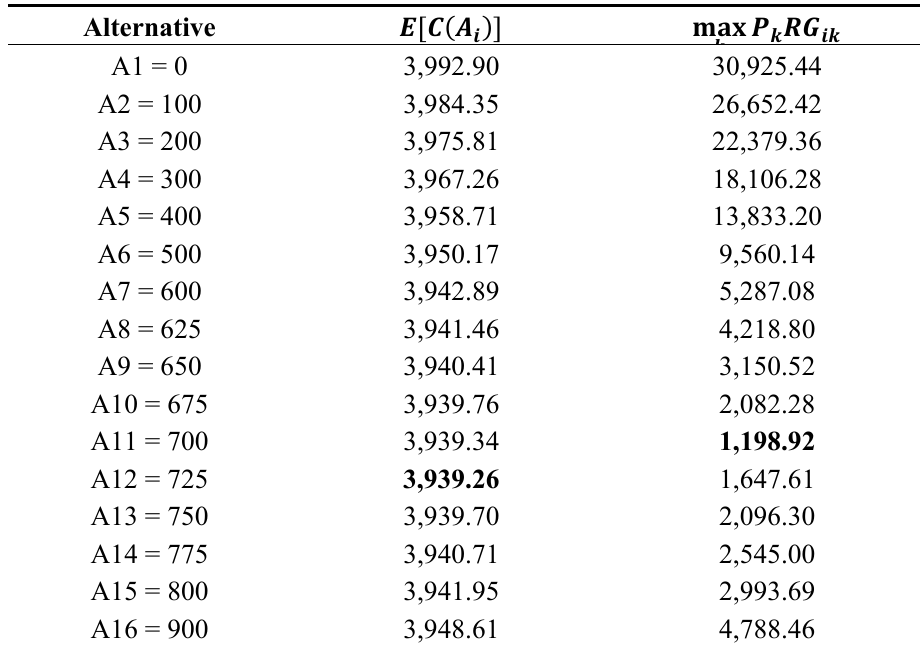
Table 3. Expected value of the costs (k$) and maximum weighted regret ($) of each alternative—Case